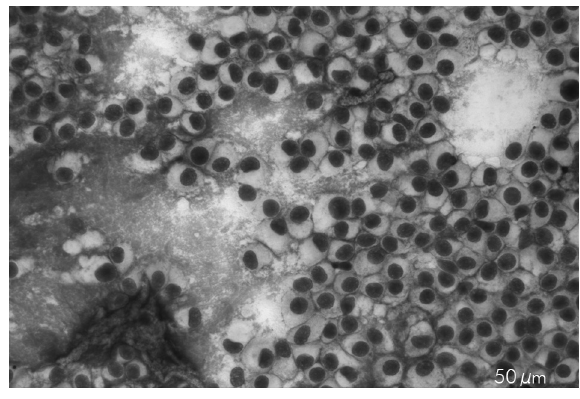
Figure 1. Presence of plasmocitoid cells on the smears with a sugestive report of Pleomorfic Adenoma (Panoptic stain).